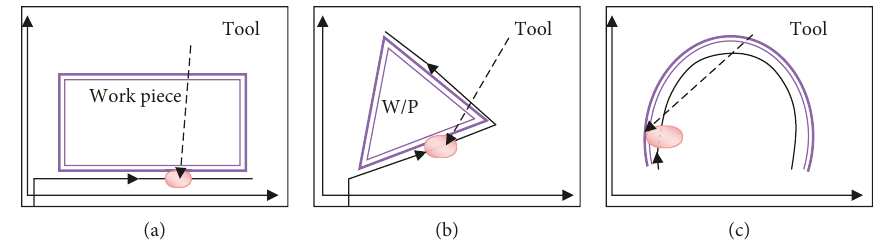
Figure 1: Different types of cut involved in the geometry. (a) Straight cut. (b) Angular cut. (c) Curvature cut.